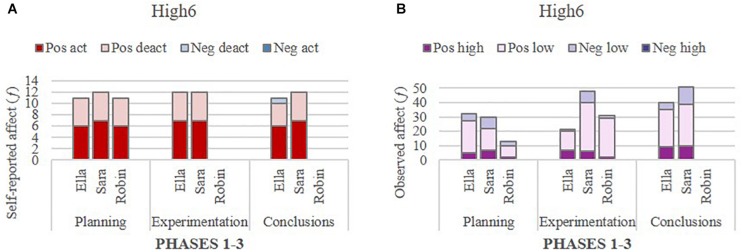
Self-reported affect (A) and observed (B) affect in the group High6.